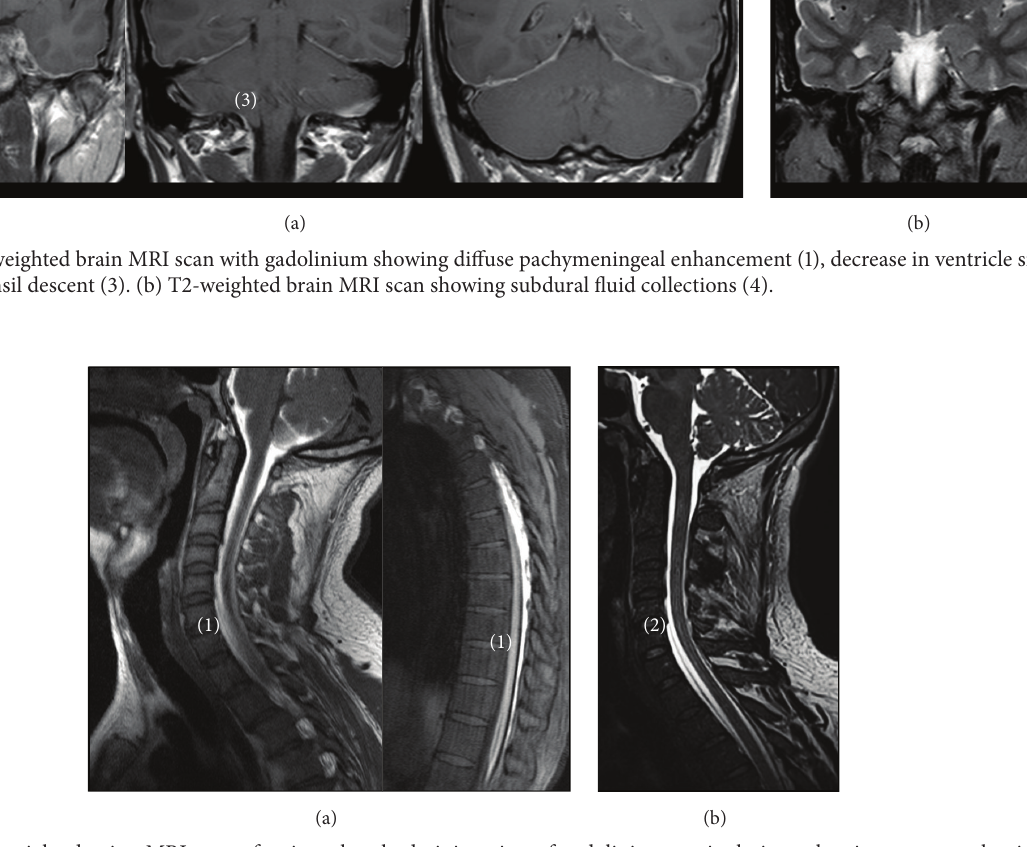
Figure 2: (a) T1-weighted spine MRI scan after intrathecal administration of gadolinium: sagittal views showing extra-arachnoid cere- brospinal fluid collections enhanced with gadolinium (1). (b) T2-weighted spine MRI scan showing subdural fluid collections and site of leak